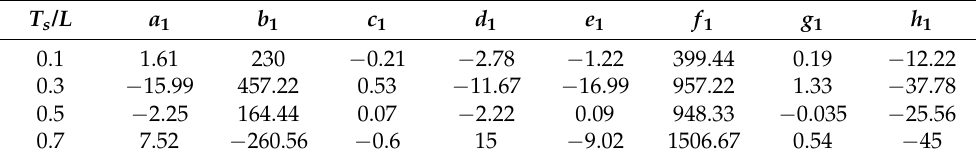
Table 3. Values of parameters related to T s / L in Equation (3) ( h 0 ).